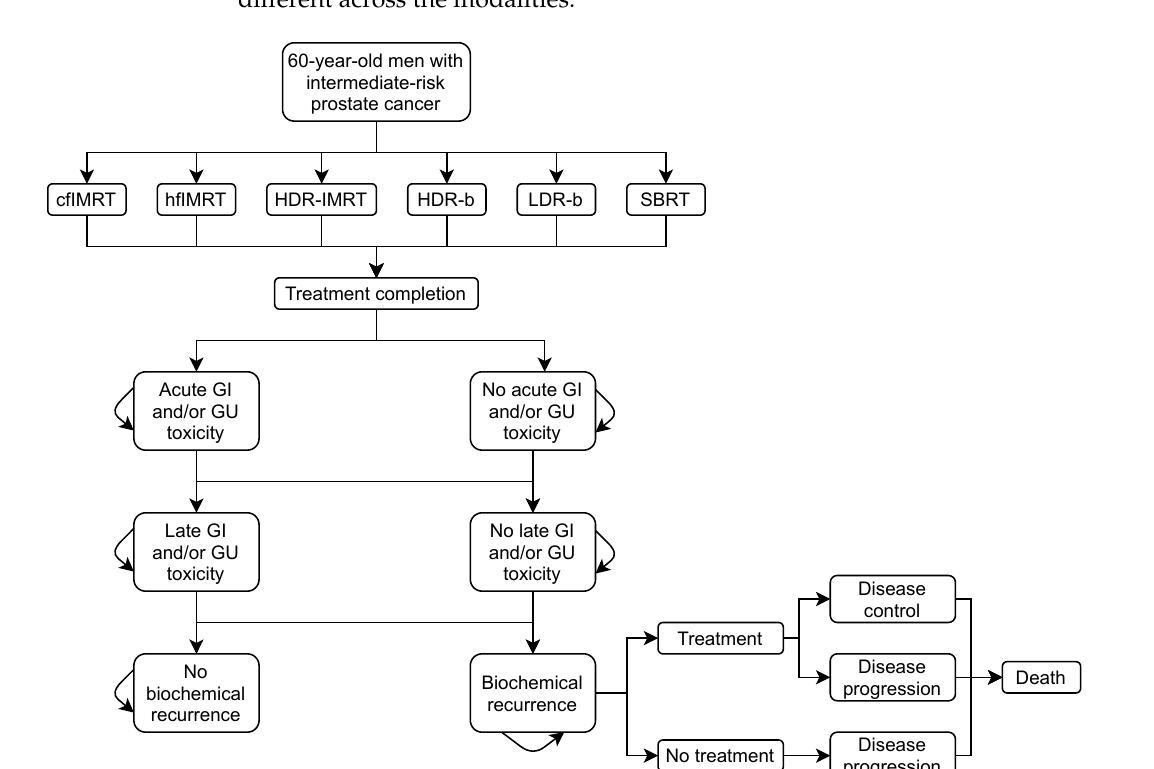
Figure 1. Model state transition diagram. cfIMRT = conventionally fractionated intensity-modulated radiotherapy; hfIMRT = hypofractionated intensity-modulated radiotherapy; HDR-IMRT = high-dose-rate brachytherapy combined with intensity-modulated radiotherapy; HDR-b = high-dose-rate brachytherapy monotherapy; LDR-b = low-dose-rate brachytherapy monotherapy; SBRT = stereotactic body radiotherapy; GI = gastrointestinal; GU =